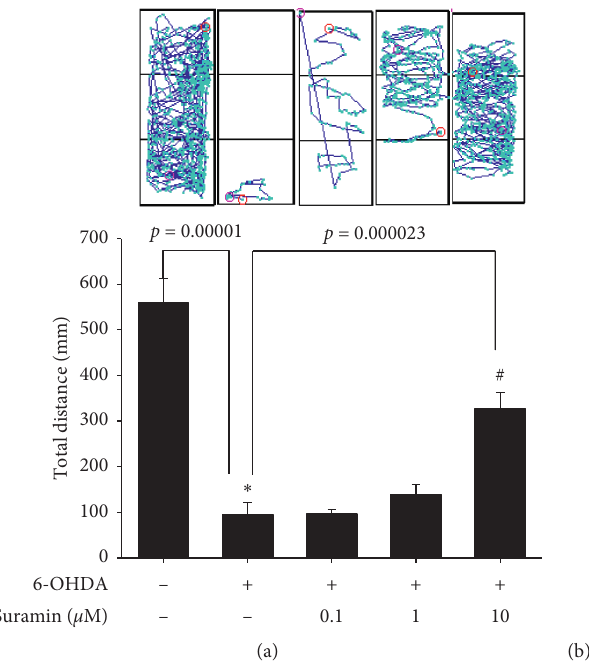
Figure 7: Effect of suramin on 6-OHDA-induced locomotor deficit and tyrosine hydroxylase (TH) expression in the zebrafish PD model. (a) Zebrafish were pretreated with 0.1, 1, and 10 μ M suramin from 9 hpf to 5 dpf and then challenged with 250 µ M 6-OHDA from 2 to 5 dpf. The upper panel demonstrates a representative swimming pattern, and the lower panel shows the average total swimming distance. (b) Zebrafish were pretreated with 10 μ M suramin from 9 hpf to 5 dpf and then challenged with 250 µ M 6-OHDA from 2 to 5 dpf. Western blotting of TH for the control, 6-OHDA, 6-OHDA plus suramin, and suramin alone groups was performed. Data are presented as mean ± SEM, and each value represents the mean of 16 samples. ∗ Significantly compared with the control group; # compared with the 6-OHDA